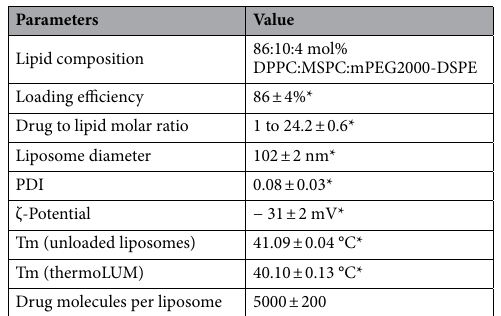
Table 1. Summary of the experimentally measured physiochemical properties of thermoLUM. *Error values represent the standard deviation (SD) obtained from three or more independent batches of